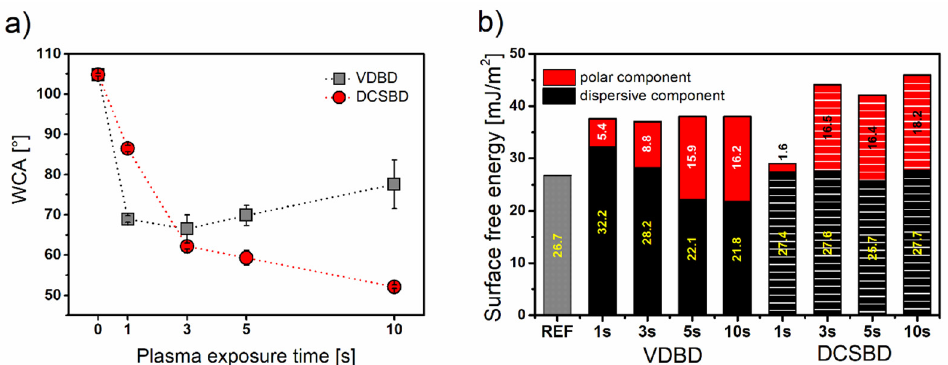
Figure 4. Graphs of WCA and SFE measurements: ( a ) WCA values measured immediately after plasma exposure of BOPP foil by VDBD (grey square) and DCSBD (red circle) for different plasma treatment times (1, 3, 5, and 10 s); ( b ) comparison of surface free energy (SFE) of BOPP foil treated by VDBD and DCSBD with inserted values of polar and dispersive component of SFE.